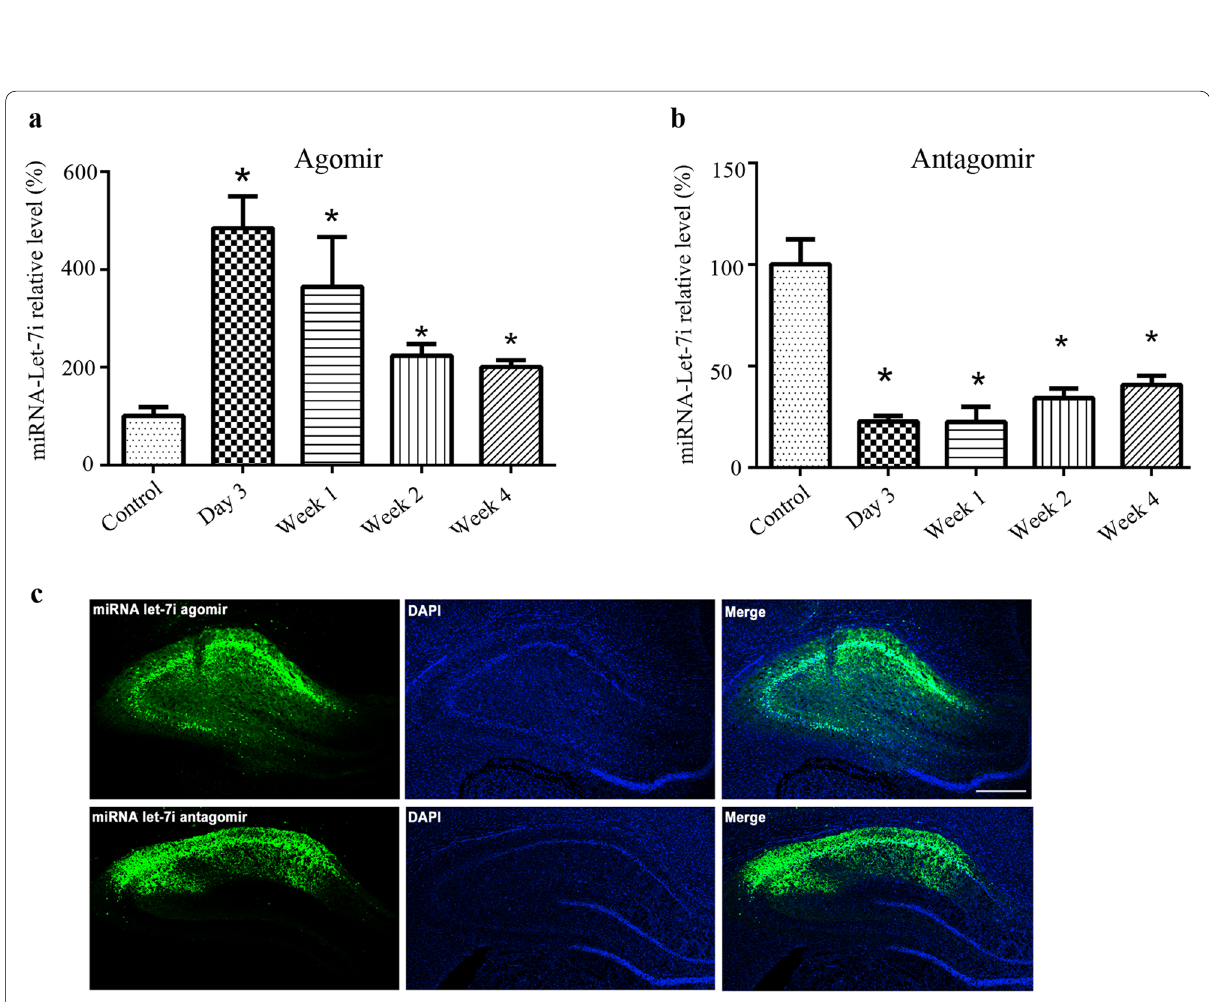
Fig. 2 Effects of the agomir and antagomir on miRNA-Let-7i expression. a Relative expression of miRNA-Let-7i in the control group and the agomir-treated group on day 3, week 1, week 2 and week 4 after pilocarpine-induced SE. b Relative expression of miRNA-Let-7i in the control group and the antagomir-treated group at day 3, week 1, week 2 and week 4 after pilocarpine-induced SE (* P < 0.05 versus control group; n group). c Representative images showing GFP expression in the CA1 and CA3 at 3 days after agomir and antagomir injection, and cell nuclei were counterstained with DAPI. Scale bar, 500